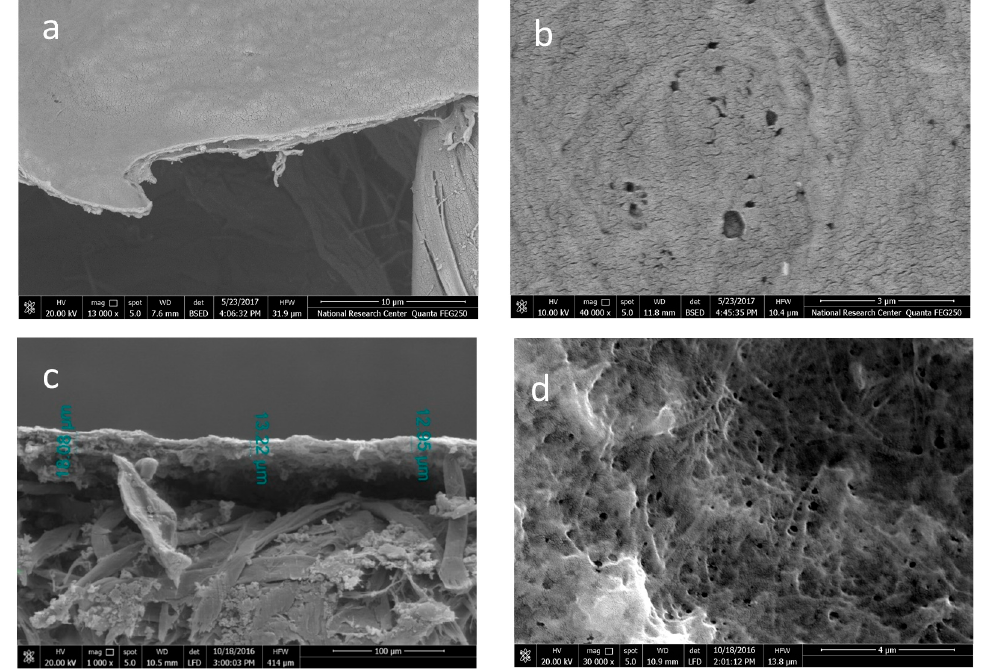
Figure 3. The cross section and surface of the oven-dried CNF membrane ( a , b ) and the CNF/AC membrane ( c , d ) formed on hardened filter paper.